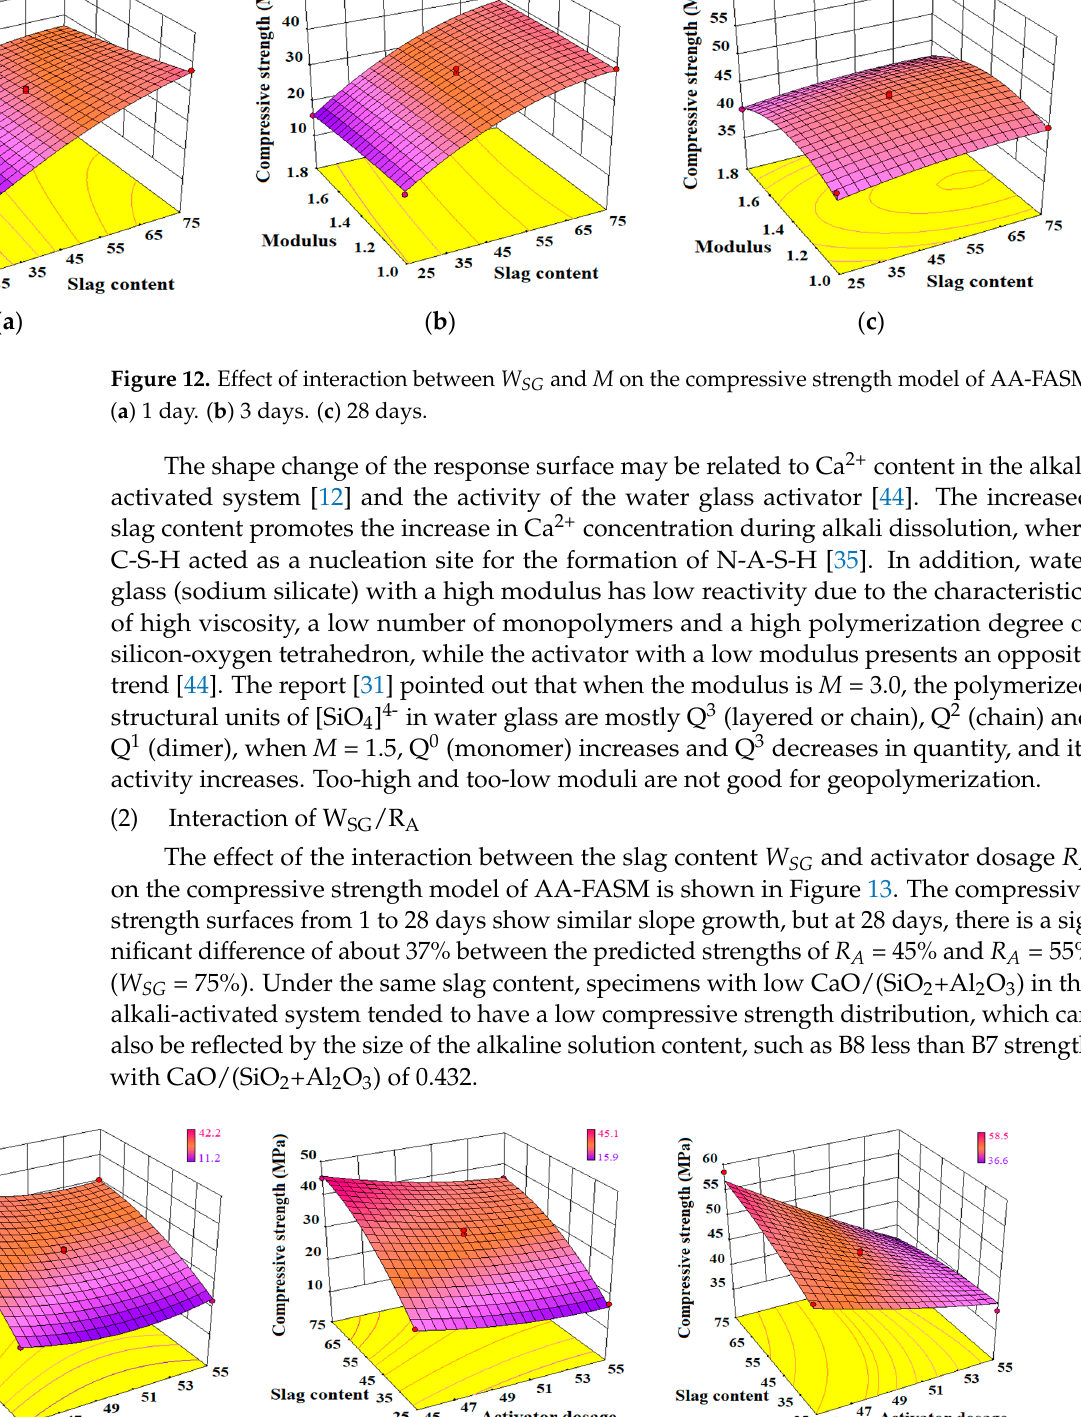
Figure 13. Effect of interaction between W SG and R A on the compressive strength model of AA-FASM. ( a ) 1 day. ( b ) 3 days. ( c ) 28 days. ( a ) 1 day. ( b ) 3 days. ( c ) 28